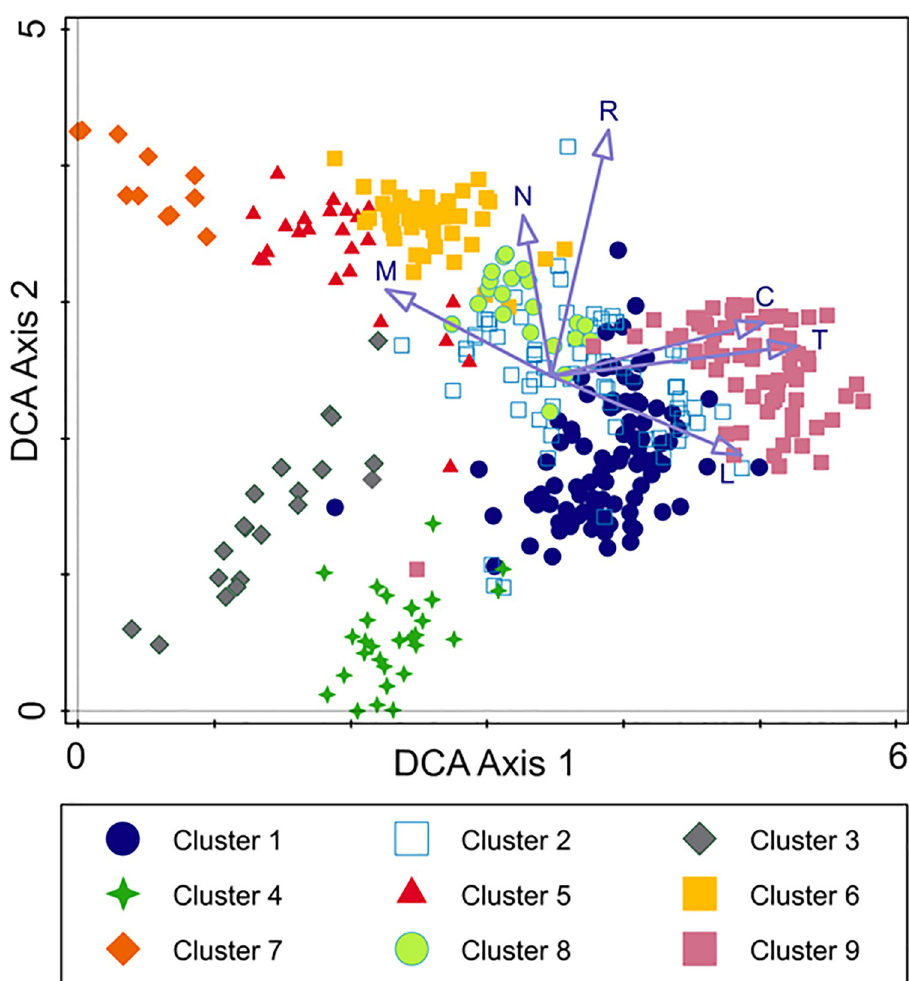
Fig 3. DCA diagram for the 387 vegetation plots of Central European rocky scrub communities with the passive projection of the mean Ellenberg’s indicator values (EIVs). Explanation: L–EIV for light; T–EIV for temperature; C– EIV for continentality; R–EIV for soil reaction; M–EIV for moisture; N–EIV for nutrients. Clusters 1–5 represent releve´s once included in the Cotoneastro-Amelanchieretum s.l. but due to differences in species composition, habitat conditions and geographical range should be treated as separate associations. Cluster 6 represents releve´s originally assigned to the ass. Cotoneastro-Amelanchieretum , but not belonging to this unit. Clusters 7–9 represent phytocoenoses with a regular occurrence of Cotoneaster integerrimus and/or Amelanchier ovalis outside the range of the Cotoneastro-Amelanchieretum s.l.. The numbers of clusters are compatible with Fig 2.